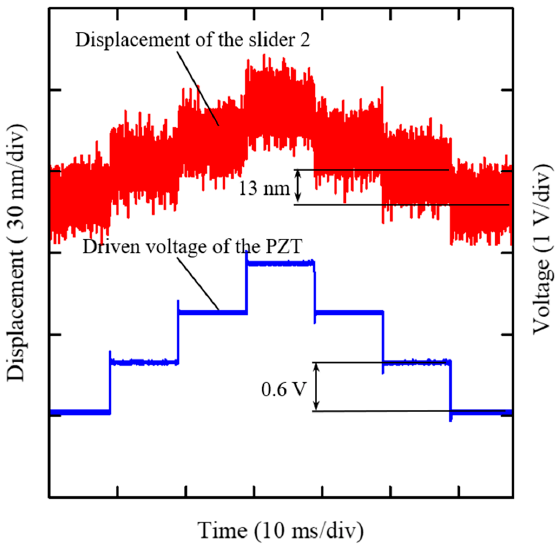
Figure 17. Actuation resolution of the SIDM mode.